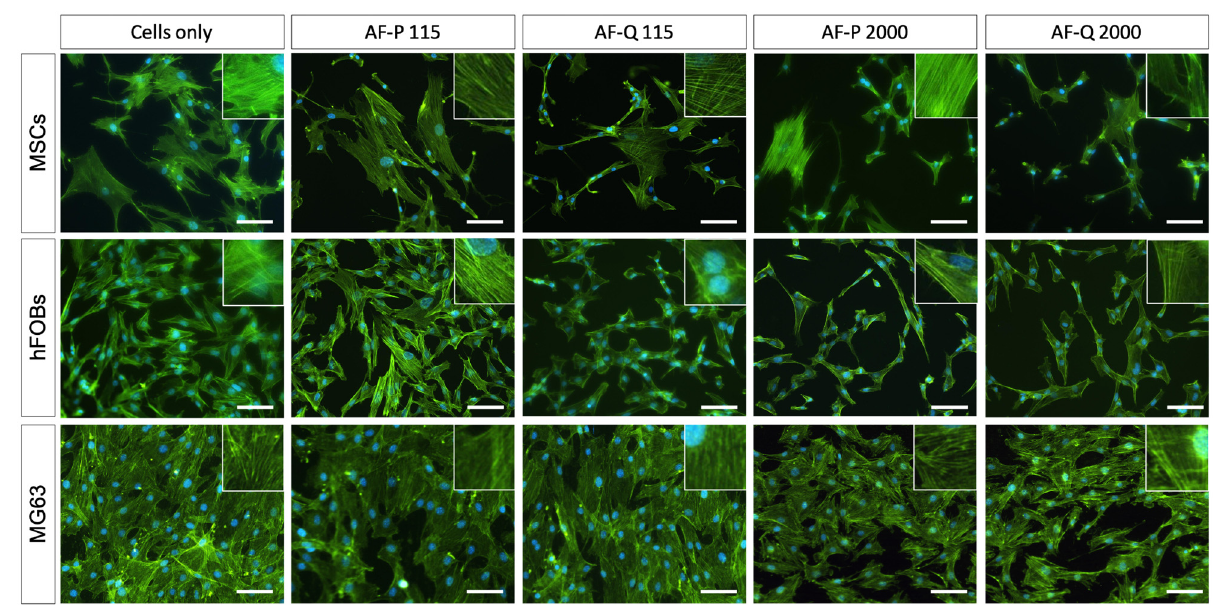
Figure 7. Morphological analysis of MSCs, hFOBs and MG63 cultured in presence of 20 µg.mL − 1 of polyplexes at N/P of 8 for 24 h. Microspheres evaluated by phalloidin staining (green: actin filaments; blue: cell nuclei). Insets: details at higher magnification. Scale bars: 100 µm.